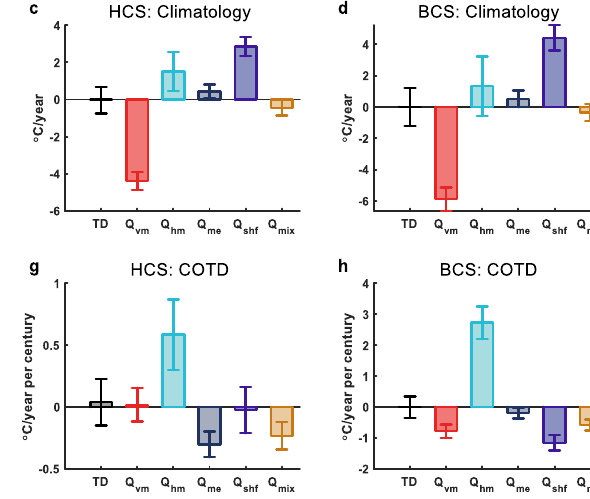
Fig. 3 | Dynamical processes responsible for the different mean-state sea sur- face temperature (SST) changes between the eastern boundary upwelling systems (EBUSs) and adjacent oceans under greenhouse warming. Climatolo- gical mean (1950 – 2000) heat budget in the upper 50m averaged over California current system (CalCS, a ), Canary current system (CanCS, b ), Humboldt current system (HCS, c ) and Benguela current system (BCS, d ) minus its oceanic counter- part, where TD is the temperature tendency, Q vm ( Q hm ) the vertical (horizontal)